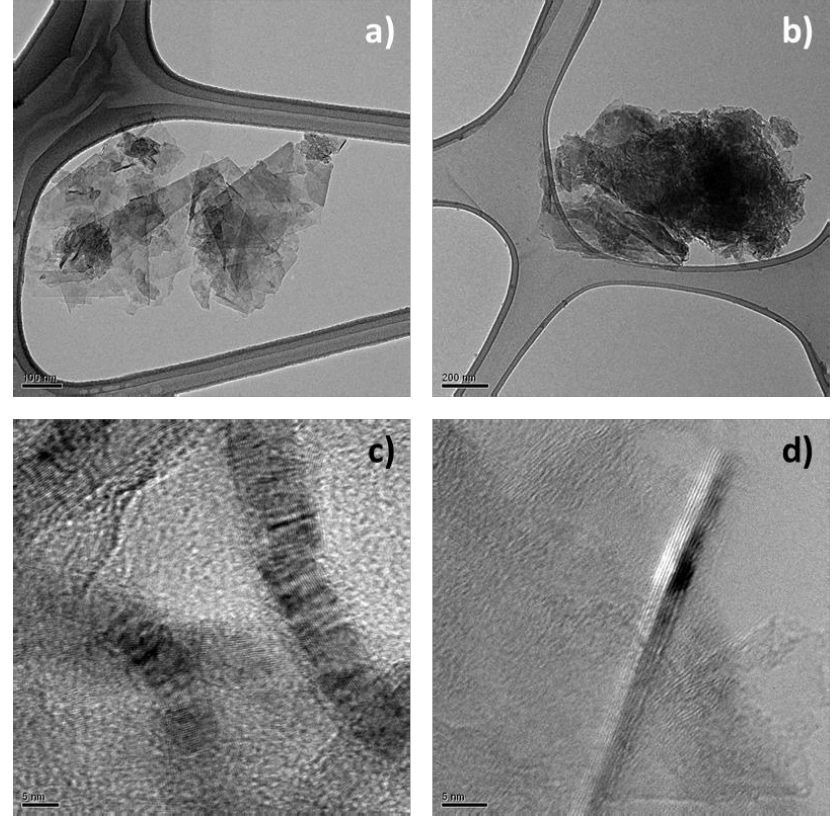
Figure 13. Micrographs of HSAG ( a,c ) and HSAG-TMP adduct obtained at 180 °C ( b,d ). Micrographs are: low magnification bright field TEM ( a, b ), HRTEM images ( c,d ).